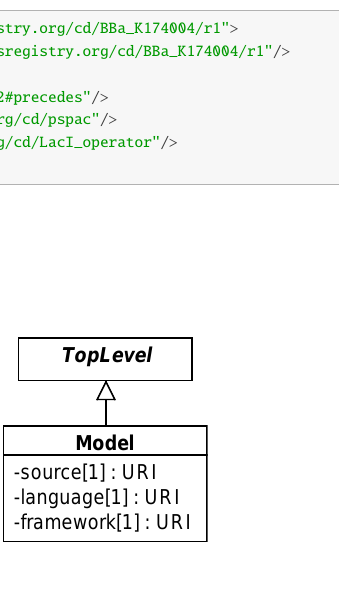
Figure 14: Diagram of the Model class and its associated